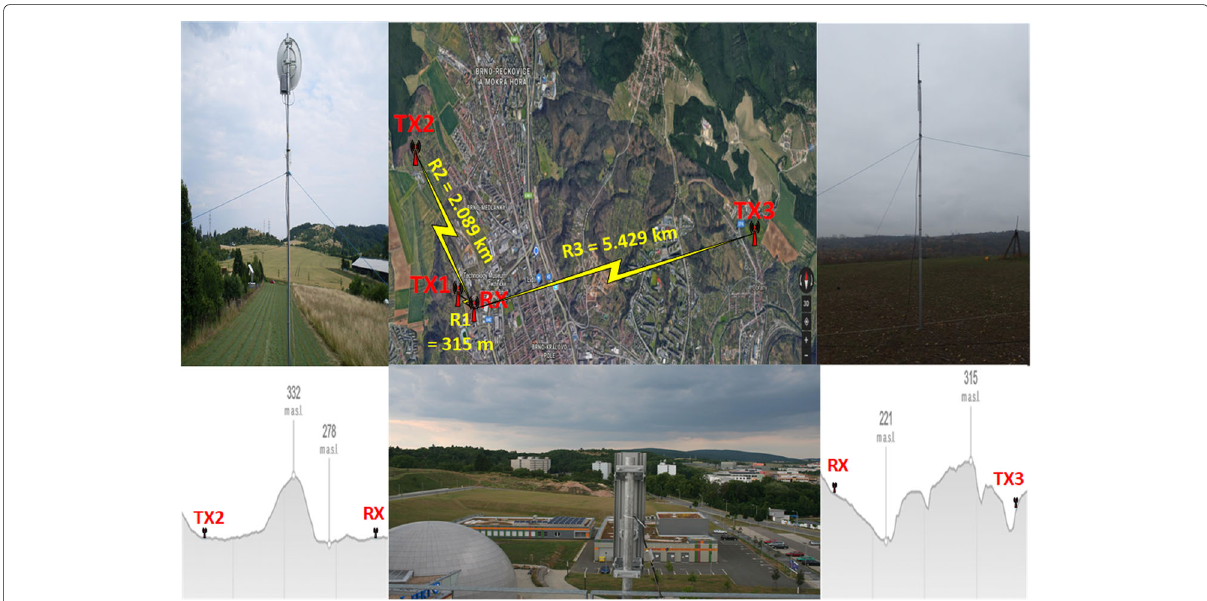
Fig. 1 Measurement locations for R1, R2, and R3 routes. Line of sight route R1 = 315 m and non-line of sight route R2 = 2.089km with super high frequency band TX2 position on the left-hand side, R3= 5.429km with ultra high frequency band TX3 position on the right-hand side and the position of the sector receiver antenna used for the super high frequency signal of TX2-RX measurements. Map source: Google.com, Mapy.cz